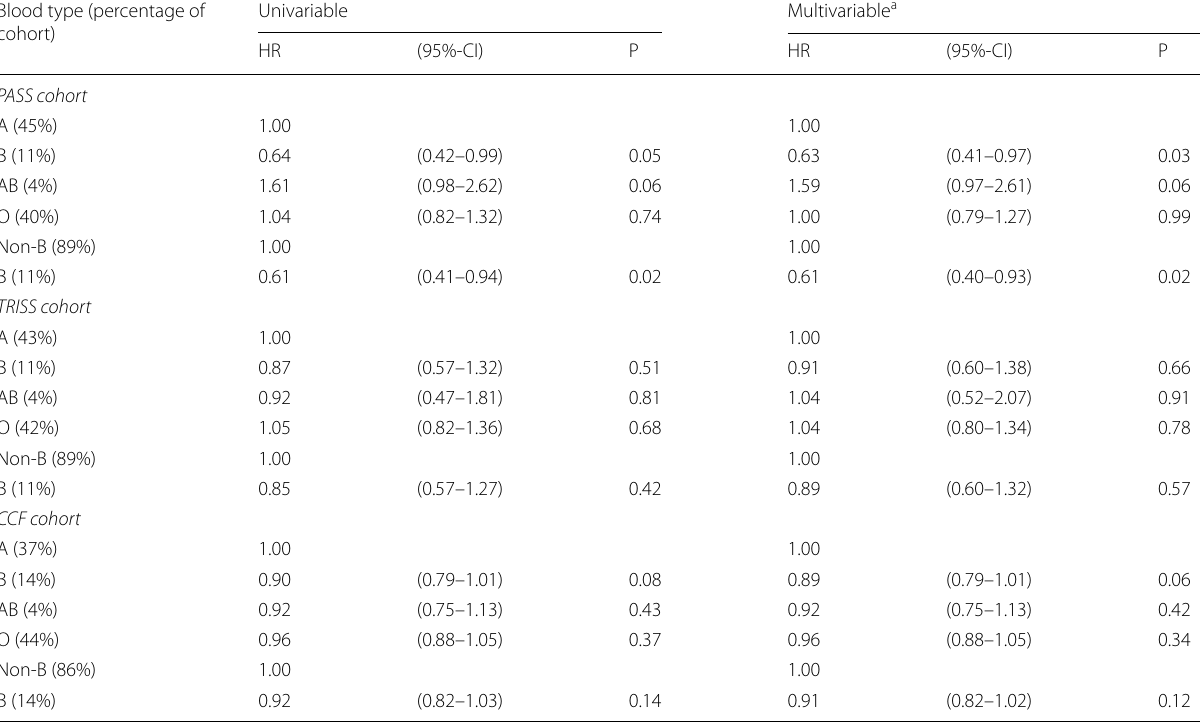
Table 2 Effect of blood type on mortality in the three ICU cohorts—Cox regression Blood type (percentage of